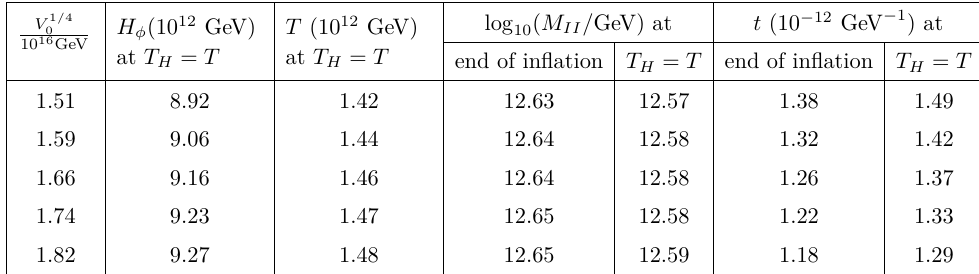
Table 8. Hubble parameter H φ from the oscillating inflaton and the temperature of the new radiation with T = T for various V 1 / 4 values corresponding to successful inflation. We also show H 0 the breaking scale M and the cosmic time t at the end of inflation and at T II After the cosmic time at T = T , the new radiation dominates over the Hawking temperature T H from field oscillations.